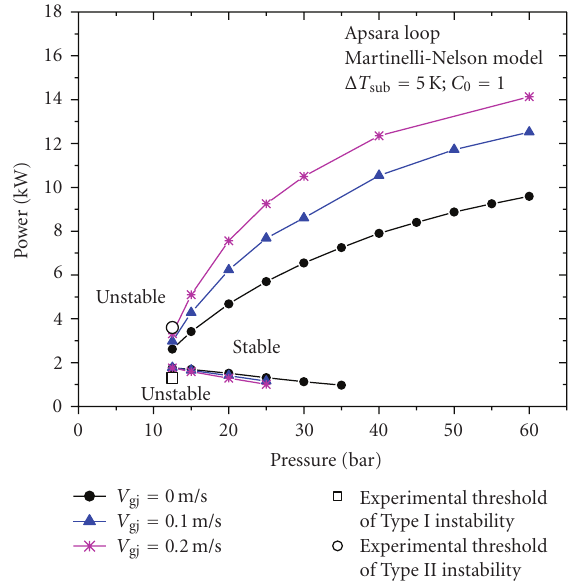
Figure 15: E ff ect of drift velocity on the Type I and Type II instabilities threshold observed in the Apsara